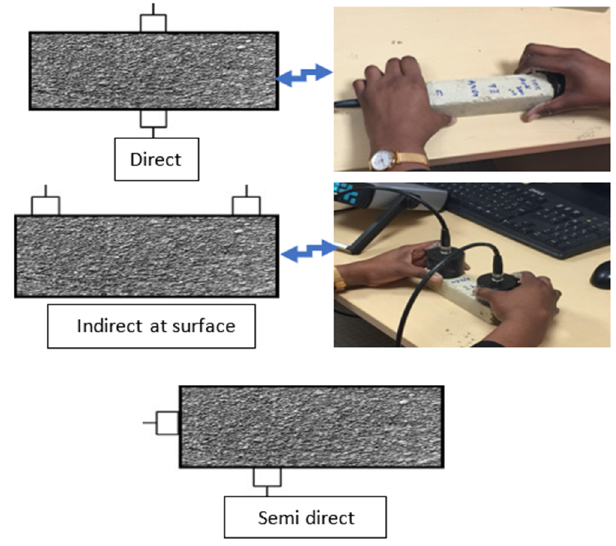
Figure 5. Different configurations for two transducers.